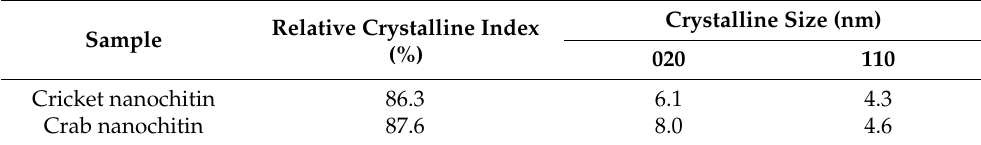
Figure 7. XRD profiles of nanochitin from cricket and crab shell. Table 1. The relative crystalline index and crystalline size of cricket and crab nanochitin.